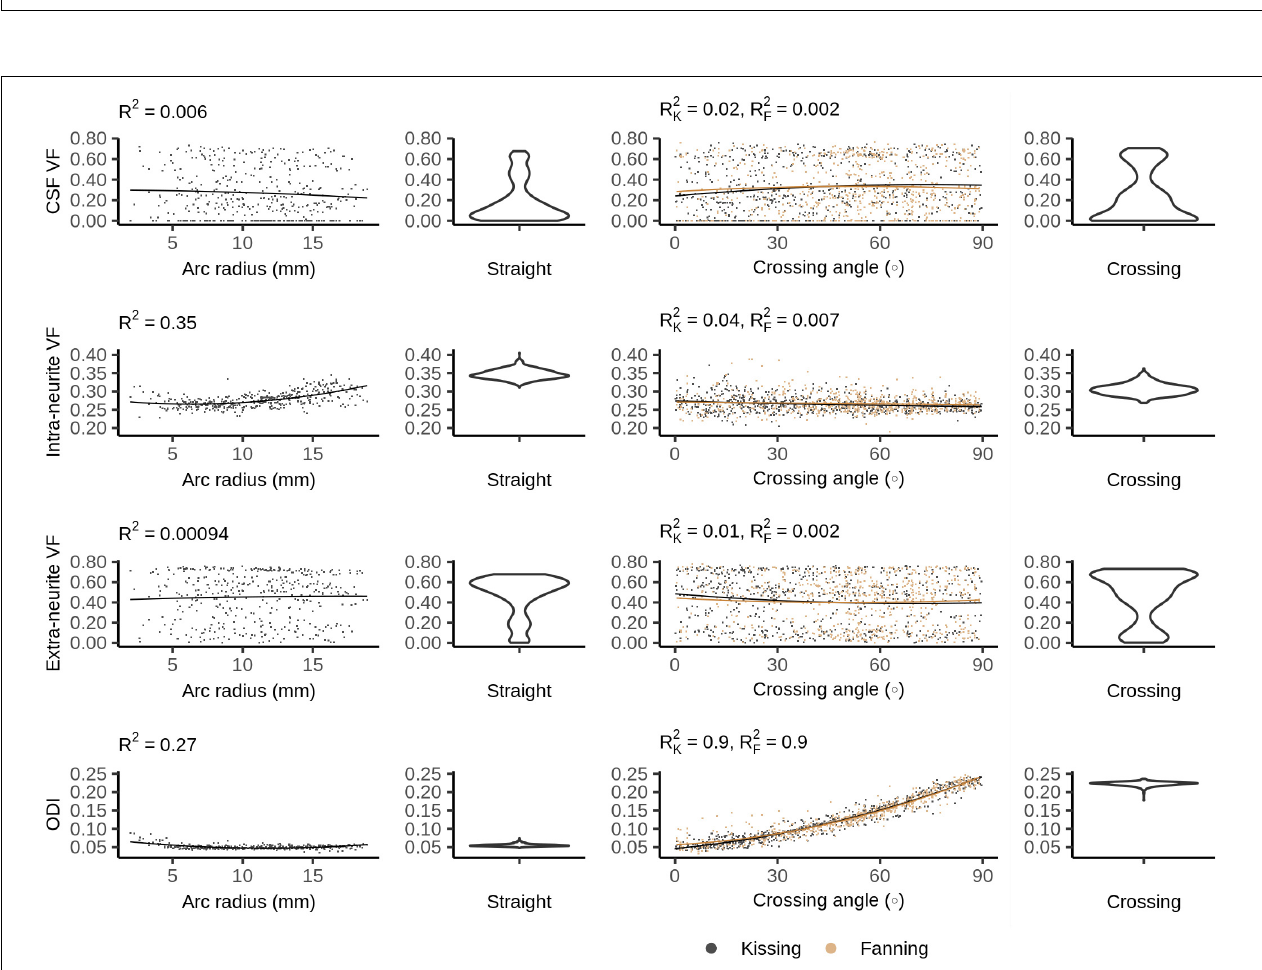
FIGURE 7 | Neurite orientation density and dispersion imaging (NODDI) metrics vs. orientation dispersion metrics in each of the four phantoms. The violin plots shown for the straight and crossing phantoms depict the probability density of values observed in the voxels of those phantoms.